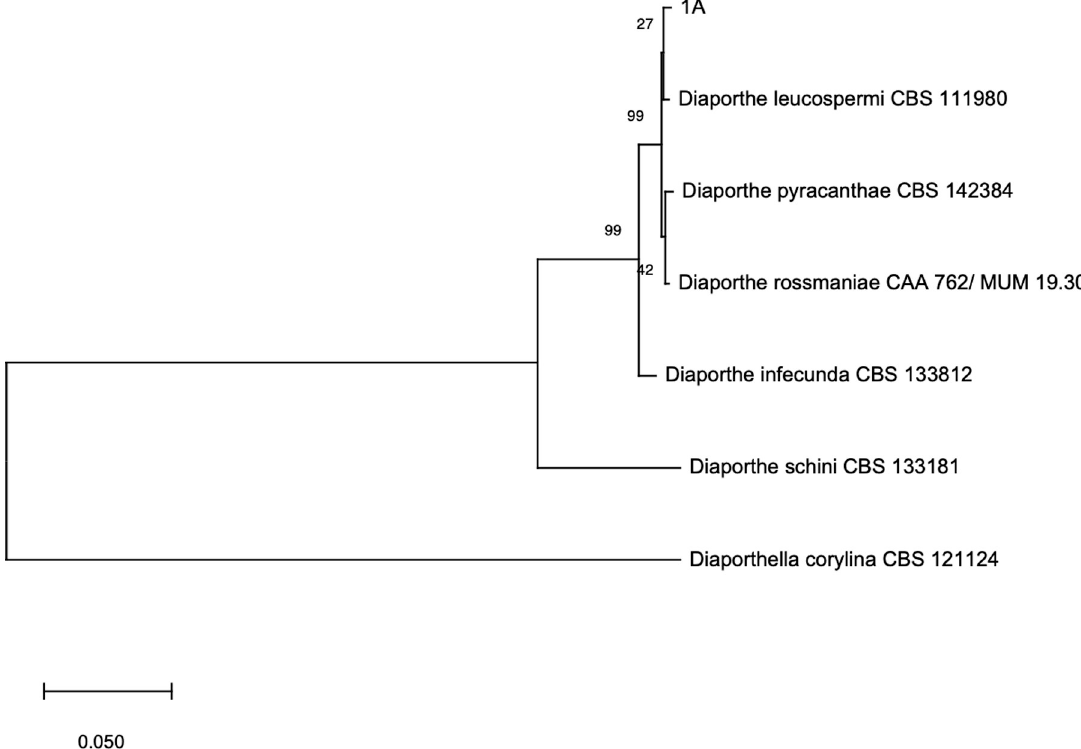
Fig 2. Maximum likelihood phylogenetic tree inferred from a concatenated dataset of ITS, tef1- α , β -tubulin, cal and his3 sequences of isolate 1A and BLAST best hits. Diaporthella corylina was used as outgroup. ML analysis was based on the Tamura-Nei model [69] and the tree was obtained from an initial bio-neighbour-joining tree automatically generated by the software, followed by a heuristic search using the nearest-neighbour interchange algorithm. A discrete gamma distribution was used to model evolutionary rate differences among sites. The percentage of trees in which the associated taxa clustered together is shown next to the